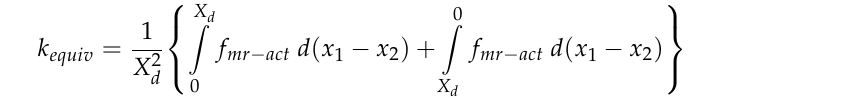
which is explained in the subsequent section. f desmr 